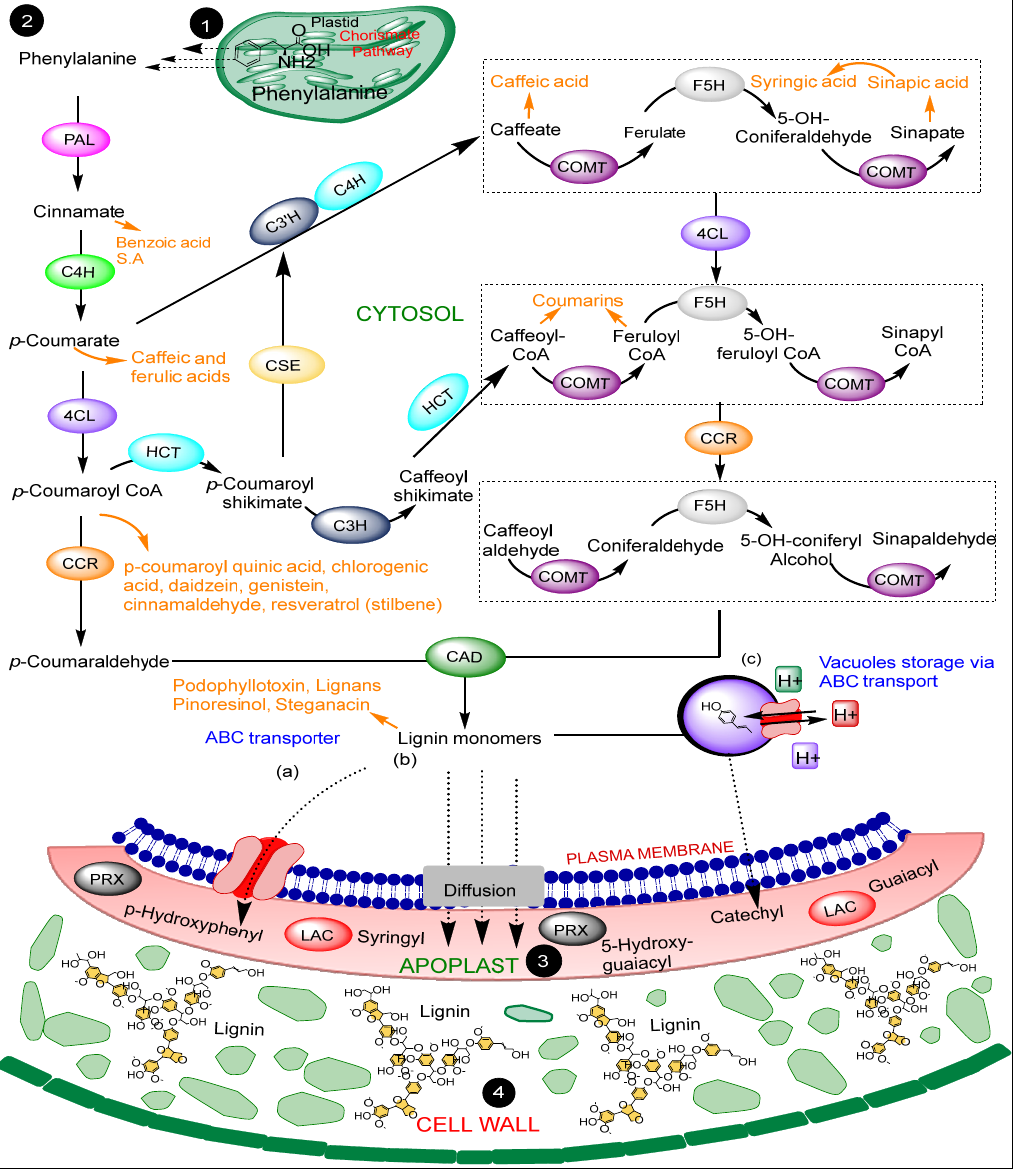
Figure 2. Defense metabolites associated with the lignin pathway and encoded by the pathway enzymes Defense metabolites are illustrated in orange, highlighting their biosynthesis routes in the pathway. The distribution of the metabolites is based on the current knowledge of their biosynthesis. Steps 1, 2, 3, and 4 are the same as in Figure 1. The proposed monolignol transport mechanisms ( a – c ) are also the same as in Figure 1.